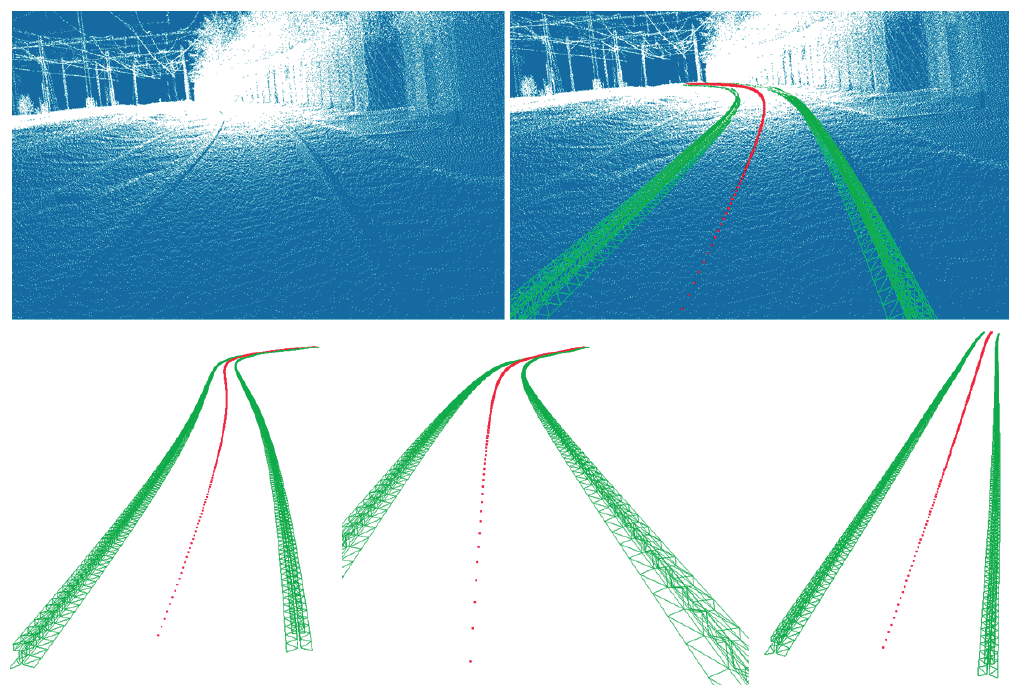
Figure 10. 3D Models and centerlines overlaid on raw point cloud